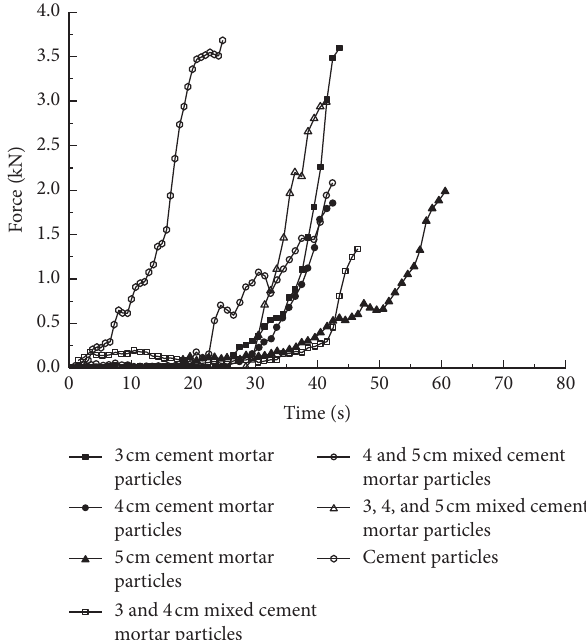
Figure 6: The local load time-history curves of different particles under the same